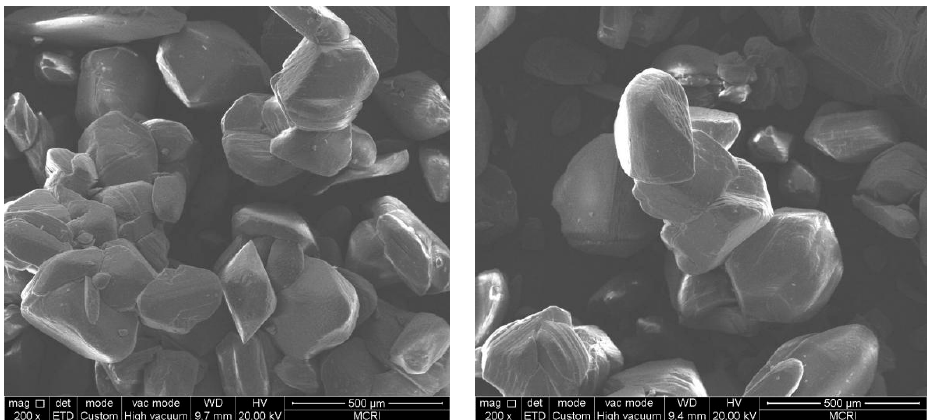
Figure 7. SEM Morphology graphs of NPTO.